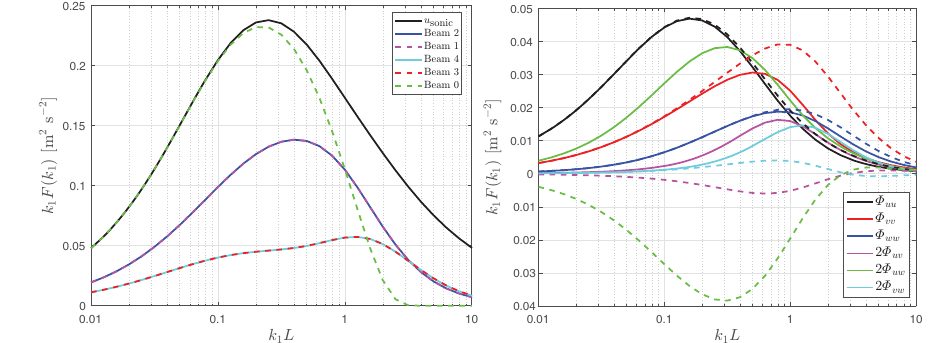
Figure 21. (Left panel) Pulsed lidar radial velocity spectra for different beams. (Right panel) Contributions of the spectral velocity tensor components to the lidar radial velocity spectrum for beams 2 (solid lines) and 3 (dashed lines). Values of β = 0 ◦ , ϕ = 60 ◦ , (cid:48) = 3, αε 2 / 3 = 0 . 1m 4 / 3 s − 2 , and z R /L = 0 . 5 are used for the computation